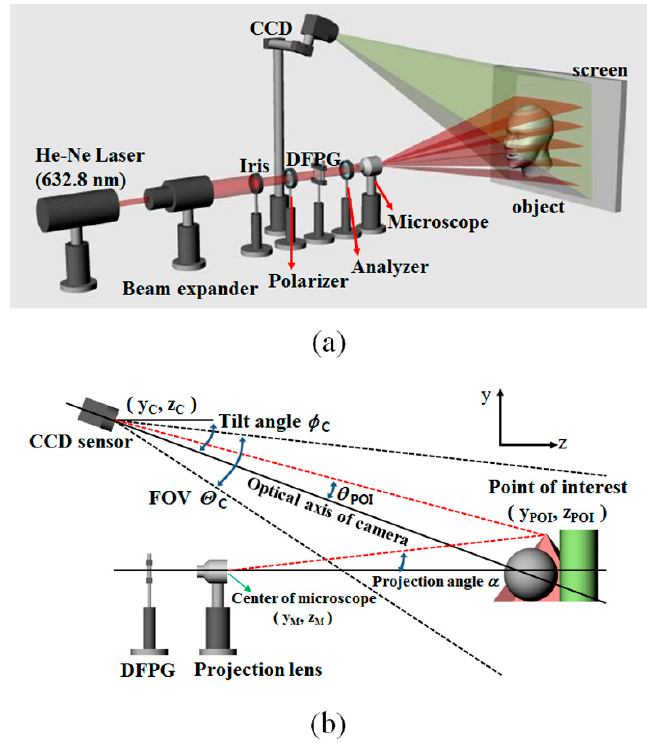
Figure 8. ( a ) Optical set-up to reconstruct the depth profile of a 3D object with the DFPG device; ( b ) Geometrical parameters of the 3D vision system used for 3D depth extraction.